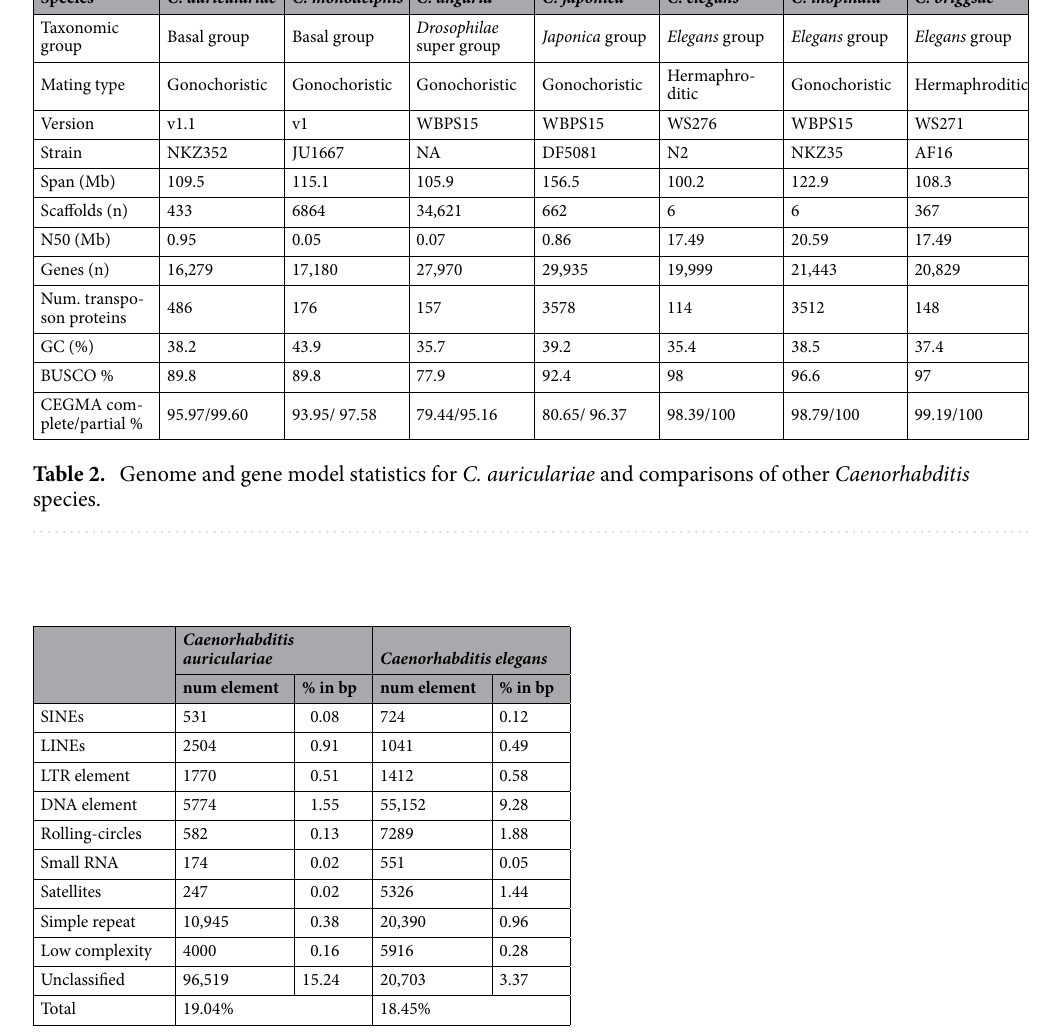
Table 3. Repeat contents in C. auriculariae and C. elegans